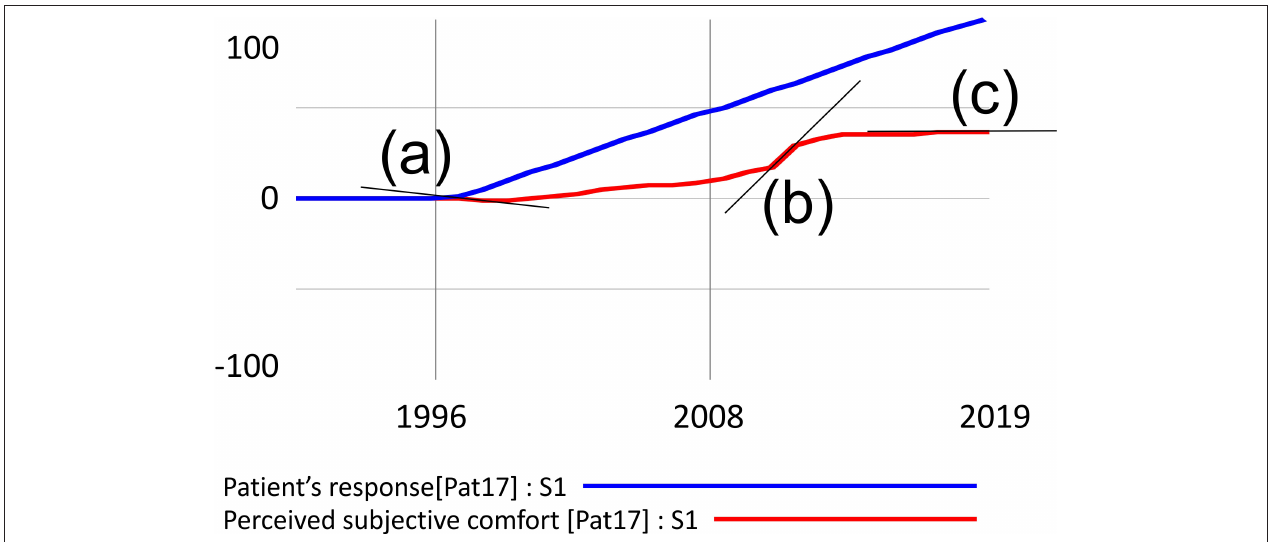
FIGURE 1 | Example of simulation output processing with three possible derivation values. The decreasing function is denoted by (a) increasing by (b) and constant by (c) .